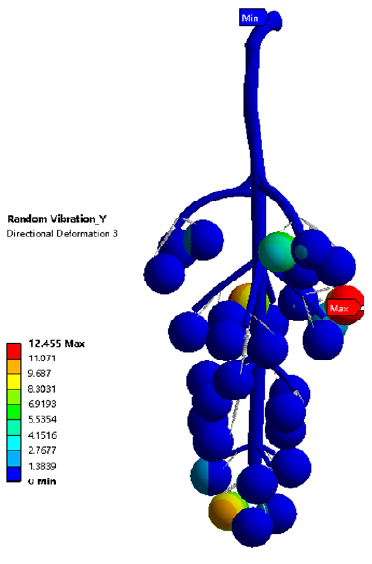
Figure 8. Vibration response in the Y direction.